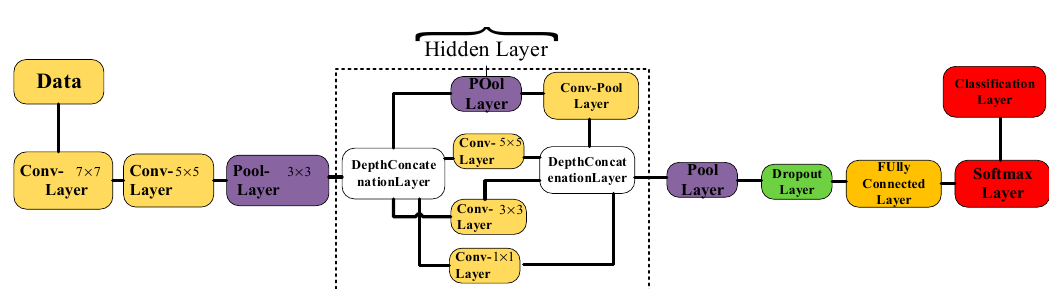
Figure 5. The block diagram of AlexNet model.